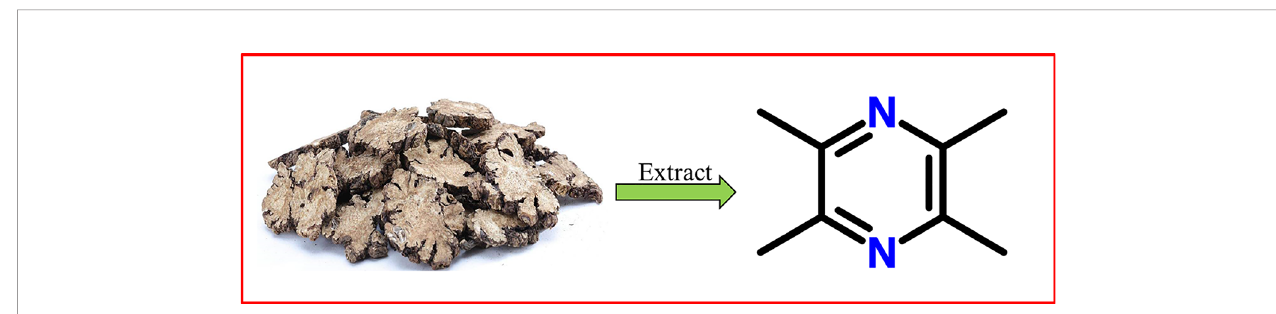
FIGURE 1 | Chemical structure of TMP. TMP,